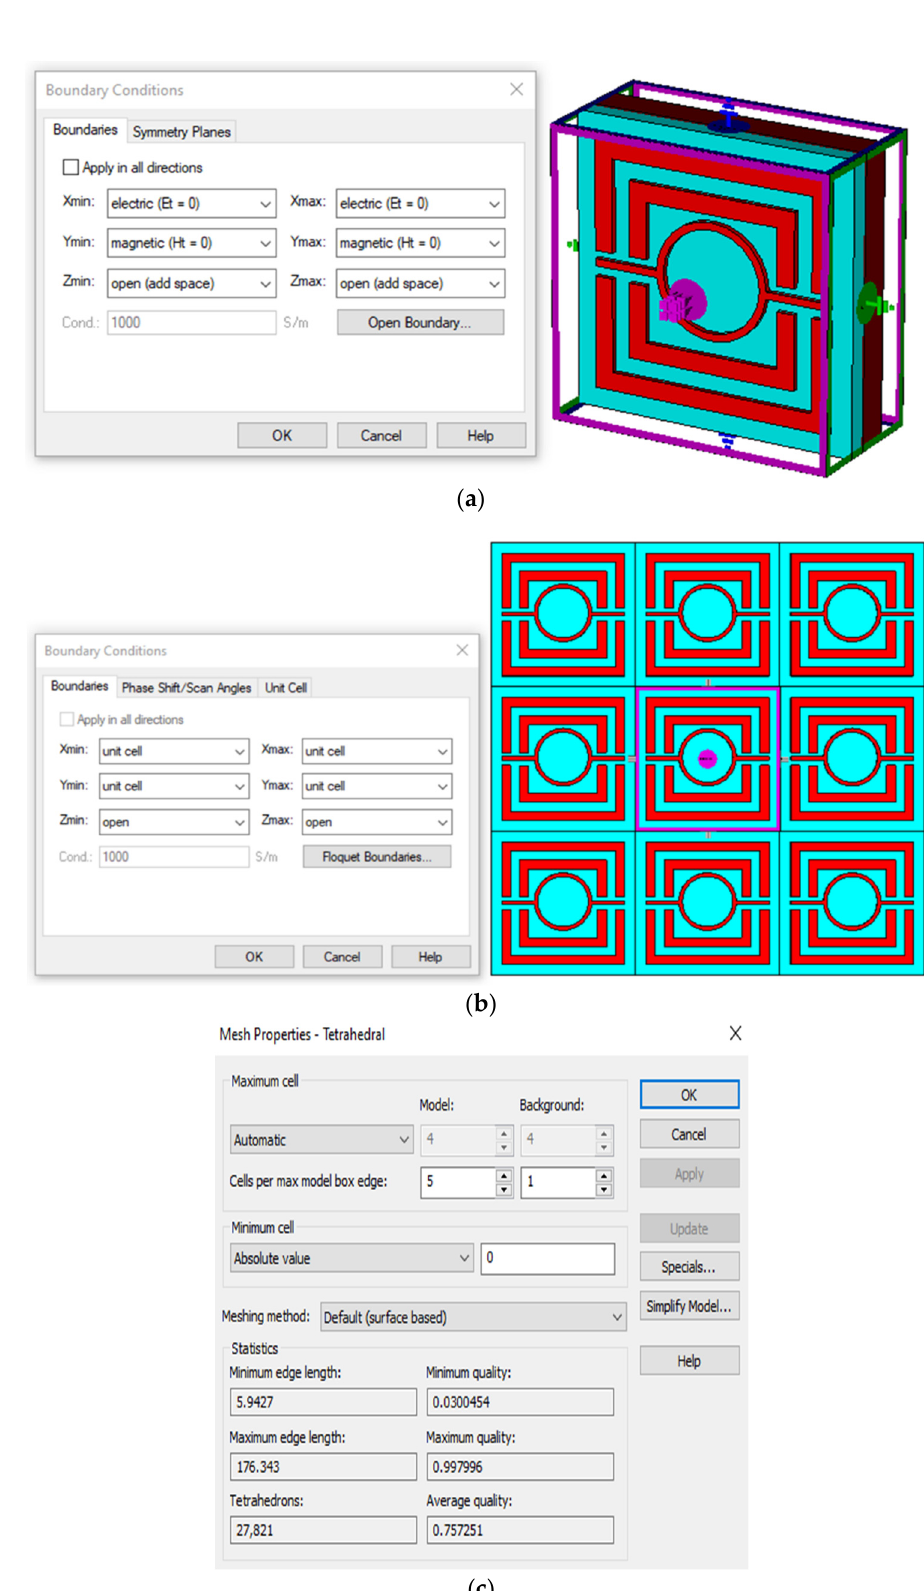
Figure 3. Setup of boundary conditions ( a ) PEC and PMC for TEM mode ( b ) Array configuration for TM and TE mode ( c ) The characteristics of the tetrahedral mesh.